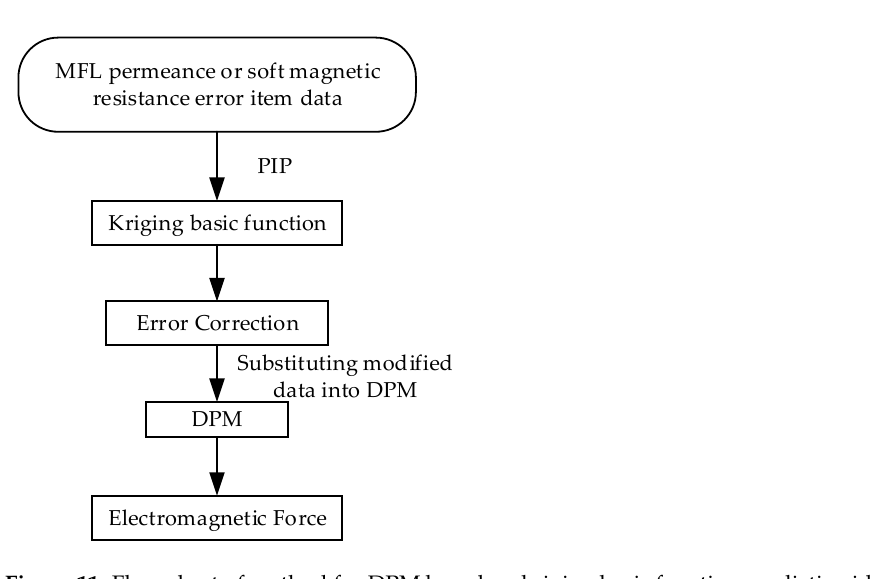
Figure 11. Flow chart of method for DPM based on kriging basis function predictive identification program (PIP) error correction.